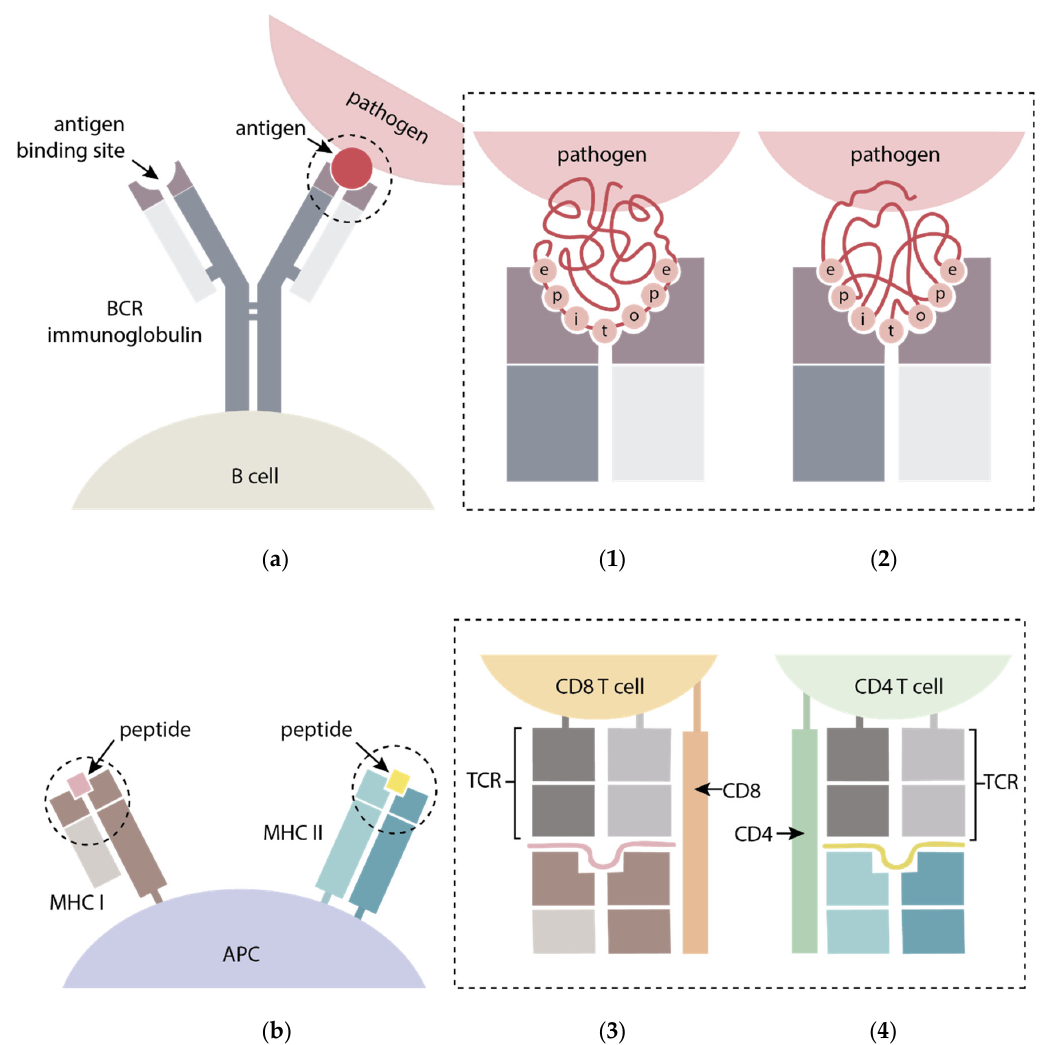
Figure 2. General scheme of ( a ) B-cell epitope recognition through: ( 1 ) linear (continuous residues); and ( 2 ) conformational (discontinuous residues) B-cell epitopes from antigens binding B-cell receptor (BCR) immunoglobulins displayed on the surface of/attached to B-cells; ( b ) T-cell epitope recognition by peptides derived from antigens presented via major histocompatibility complex (MHC) I and II molecules bound to APCs and recognized by ( 3 ) CD8+ and ( 4 ) CD4+ T-cells T cell receptors (TCR), respectively. Adapted from [28,29] .